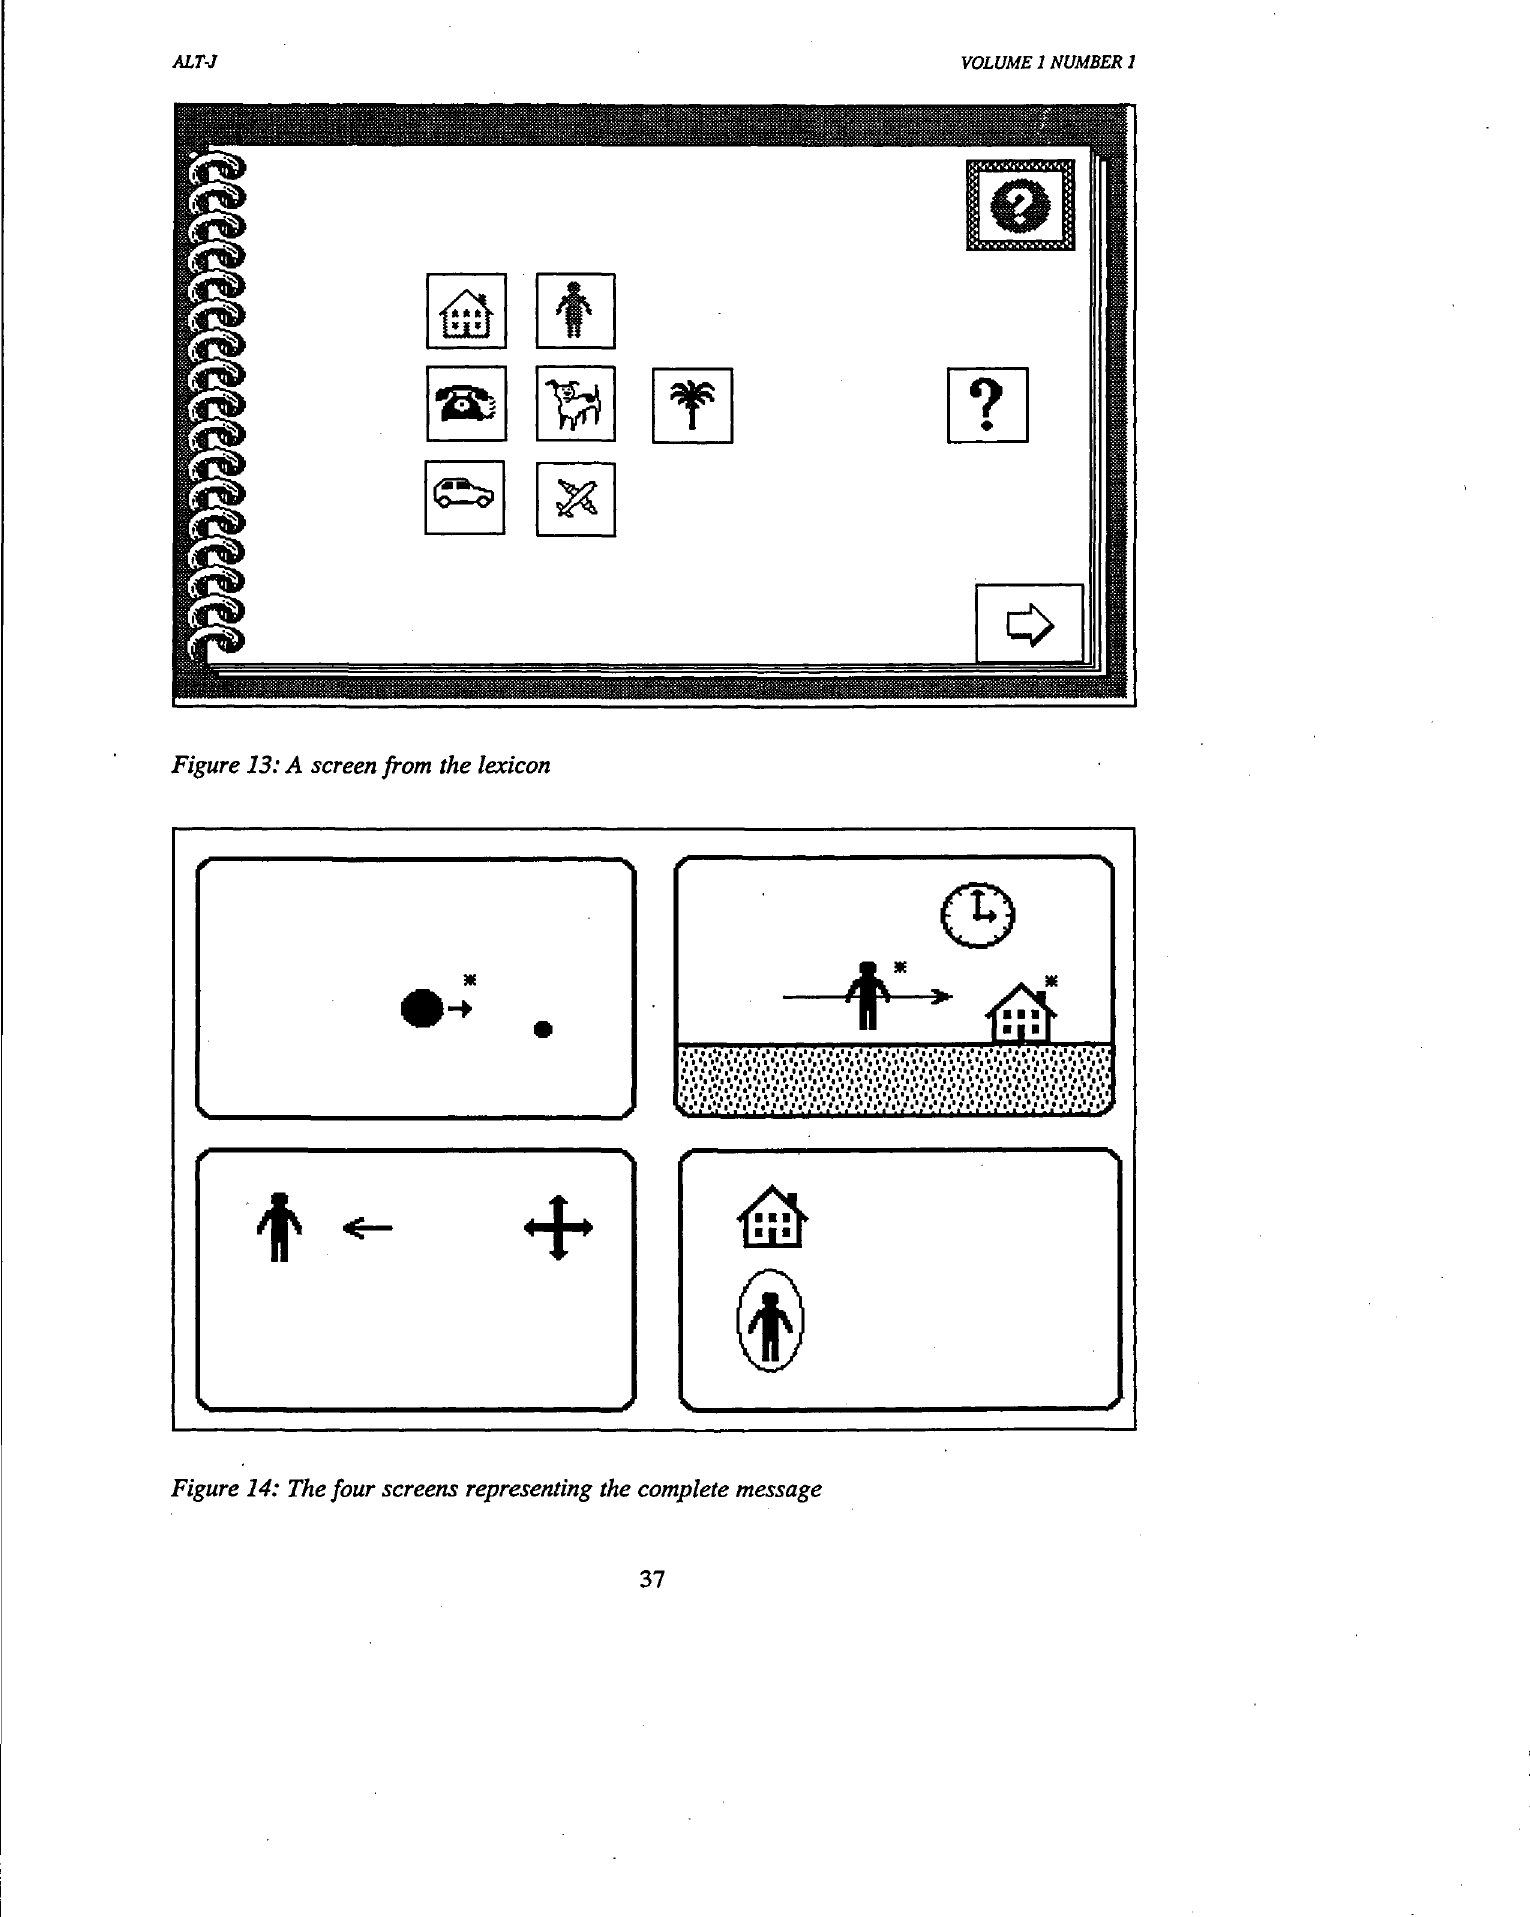
Figure 14: The four screens representing the complete message